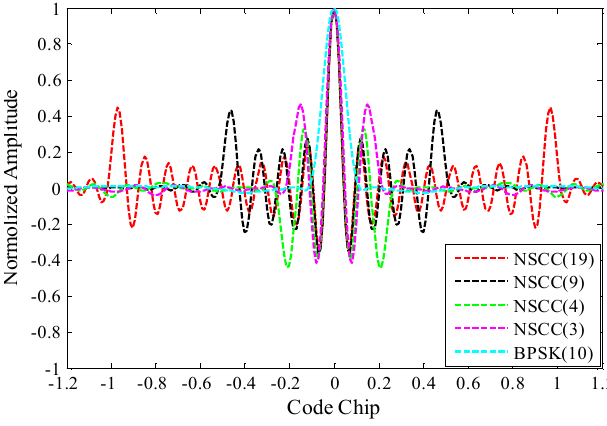
Figure 4. ACFs for monomodal NSCCs with different sub-carriers in 20 MHz bandwidth.